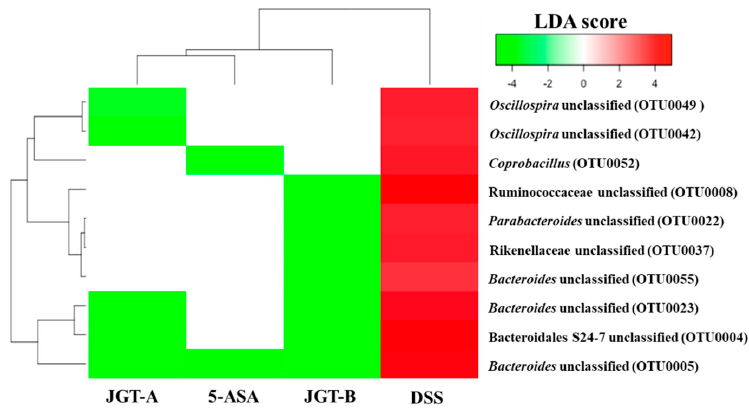
Figure 4. Heatmap analysis of OTUs that were significantly increased by the DSS treatment but significantly decreased by the treatments based on LEfSe results (LDA > 3, p < 0.05). The DSS and control groups were compared to identify OTUs that were significantly increased by DSS. DSS and treatment groups were compared to identify OTUs that were significantly decreased by